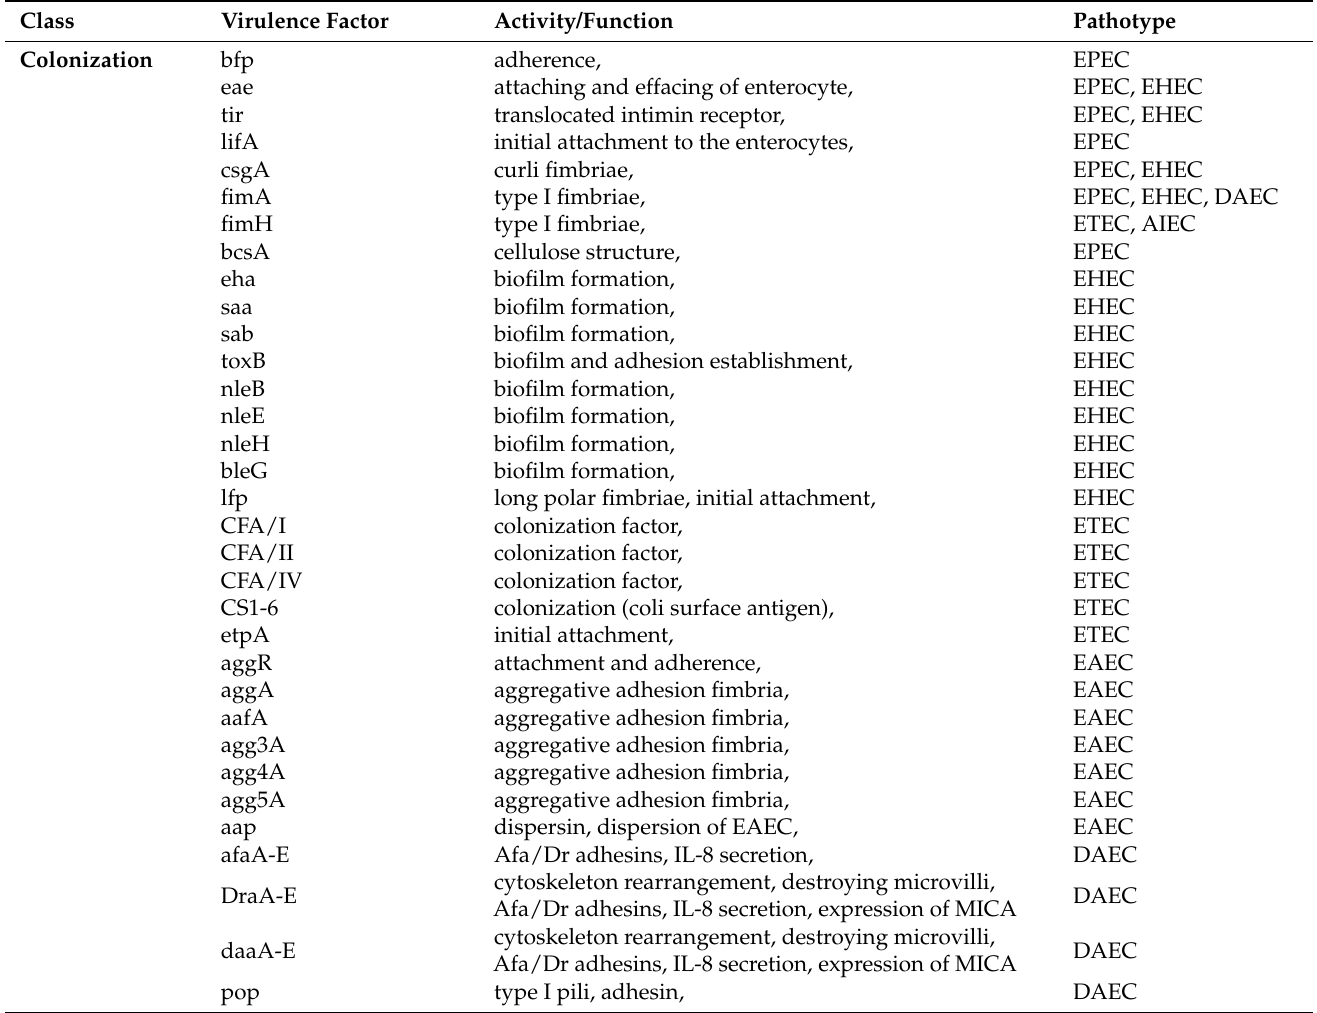
Table 1. Virulence factor genes of enteric E. coli pathotypes: Colonization, fitness, toxins, and effectors.